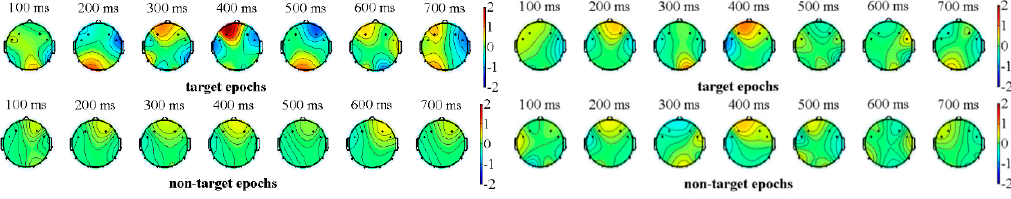
Figure 4. Brainwave activity mapping of target and non-target source stimulation from subject a and his corresponding impostor fa.